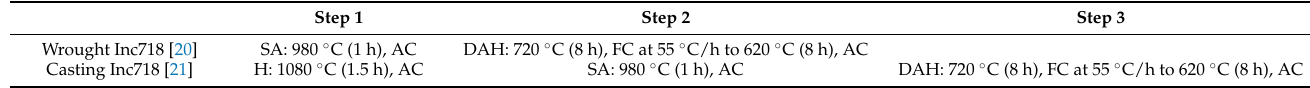
Table 3. Industrial standard heat treatment cycles for wrought and casting Inc718.